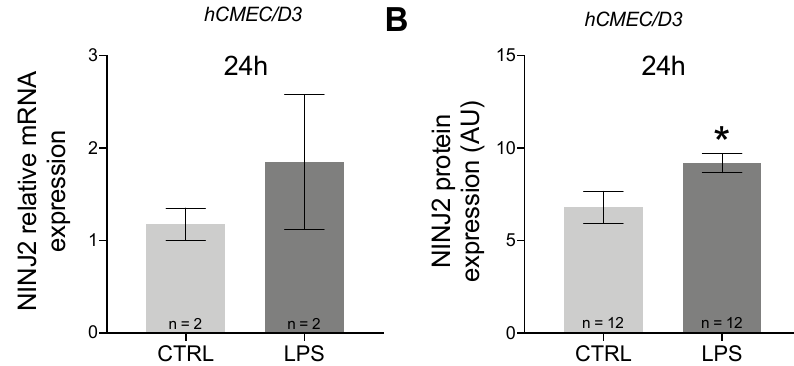
Figure 2. NINJ2 is up-regulated after LPS stimulation in hCMEC/D3 cells. ( A ) The relative gene expression of NINJ2 was measured in hCMEC/D3 cells stimulated with LPS (1 μ g/mL) for 24 h. ( B ) The NINJ2 protein level, expressed as mean fluorescence (arbitrary units, AU), was measured in hCMEC/D3 cells stimulated with LPS (1 μ g/mL) for 24 h; data are reported as mean ± SEM from a total of 12 analyzed cells for each condition. Data are reported as mean ± SEM. CTRL: unstimulated condition, LPS: stimulated condition. * p < 0.05.